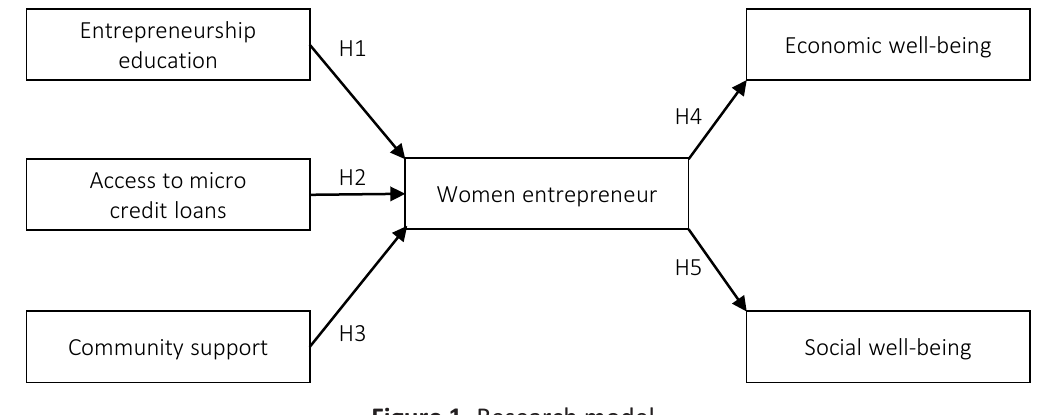
Figure 1. Research